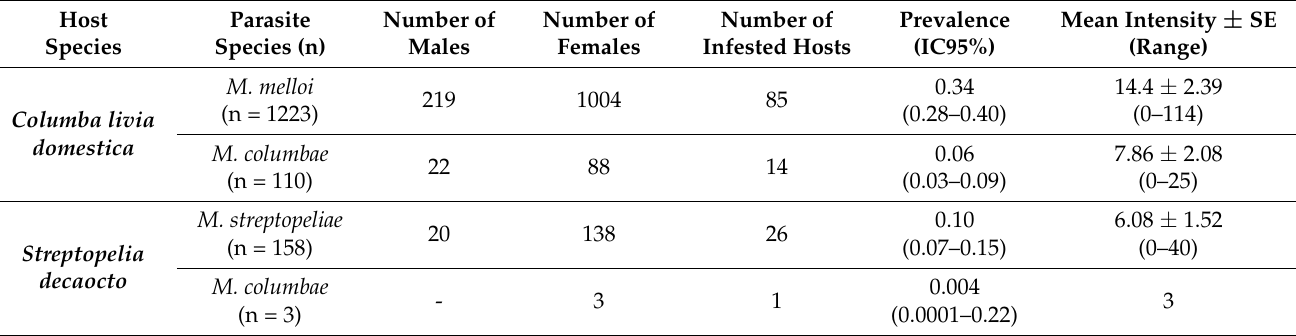
Table 1. Epidemiological information of each parasitic mite species in each host species. The table shows the prevalence with 95% confidence intervals (in brackets) and the mean intensities with their standard error and the range of mites collected per host. Total number of each mite species collected per host species (n), total number of male and female mites of each species and total number of infested hosts with each mite species is also shown.